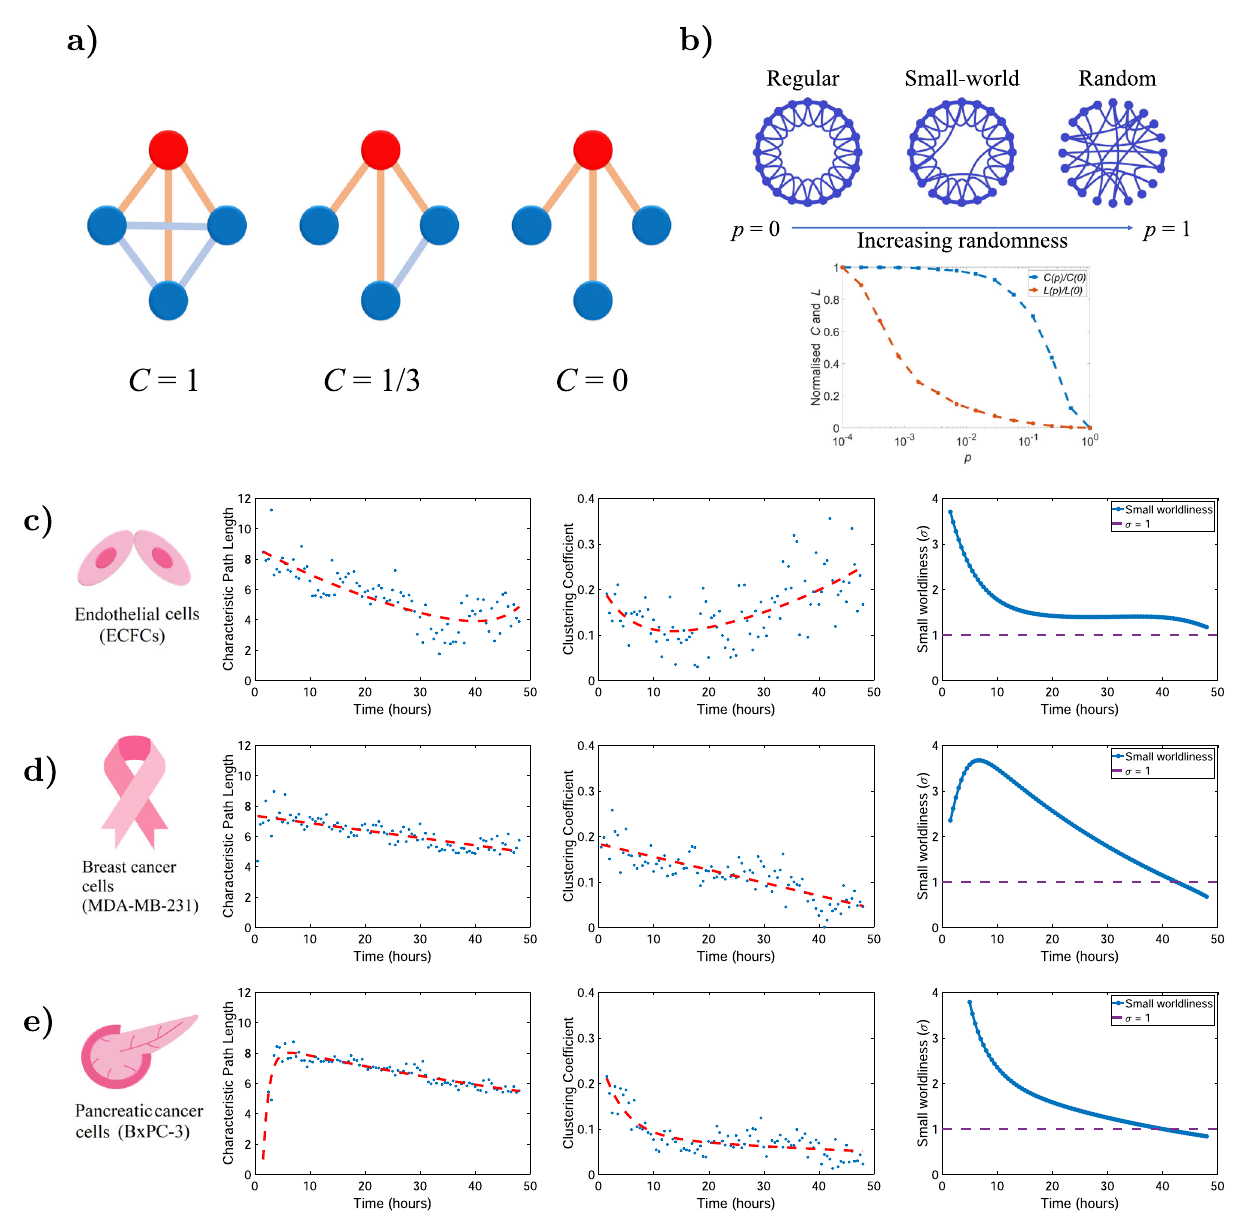
Fig. 3 Small-worldness, characteristic path length and clustering coef fi cient for ECs, breast cancer cells and pancreatic cancer cells. a An example of clustering coef fi cient on an undirected graph is shown. The local clustering coef fi cient of the red node is obtained as the proportion of connections among its neighbours which are actually realised compared with the number of all possible connections. b The Watts-Strogatz model 31 and the generation of small-world networks. The model starts with a regular lattice network. Then, with probability p , edges are rewired uniformly at random such that at p ¼ 0 the network is a regular lattice and at p ¼ 1 the network is random. At intermediate values of p , the network has so-called small-world characteristics with considerable local clustering (from the lattice network) and short characteristic path length (from the random network). c Analysis is of fi ve angiogenic networks formed by ECs with the average shown for each time point. The dashed red line is fi tted on the data showing clustering coef fi cient decays in the EC case; however, clustering coef fi cient increases. Here, VM networks were similarly analysed from fi ve d breast cancer and fi ve e pancreatic cancer networks separately and the mean determined over time. Exponential lines are fi tted to the characteristic path length and clustering coef fi cient. Both characteristic path length and average clustering coef fi cient drop over time in VM